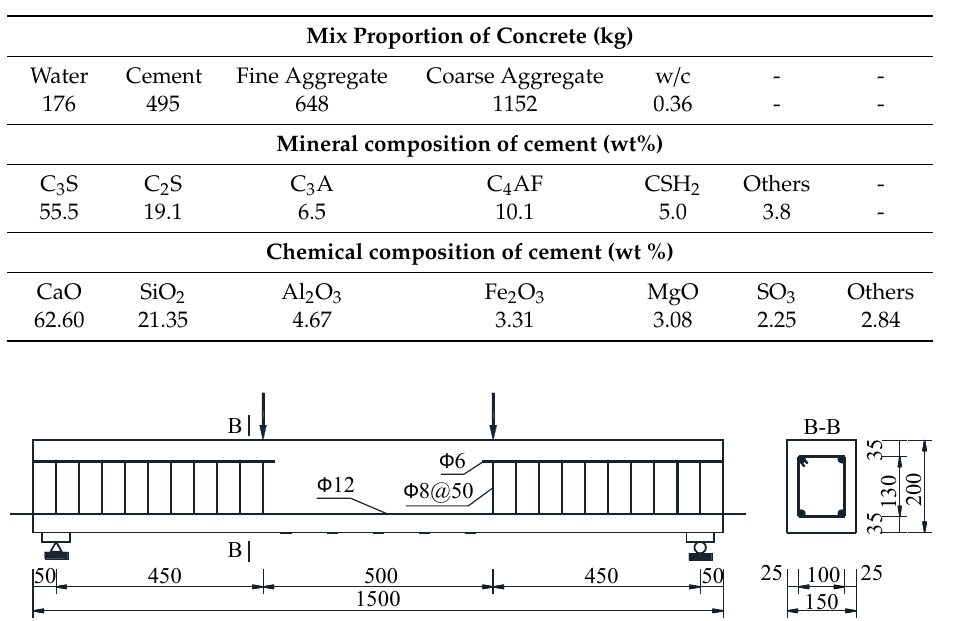
Table 2. Mix proportion, mineral composition, and chemical composition.